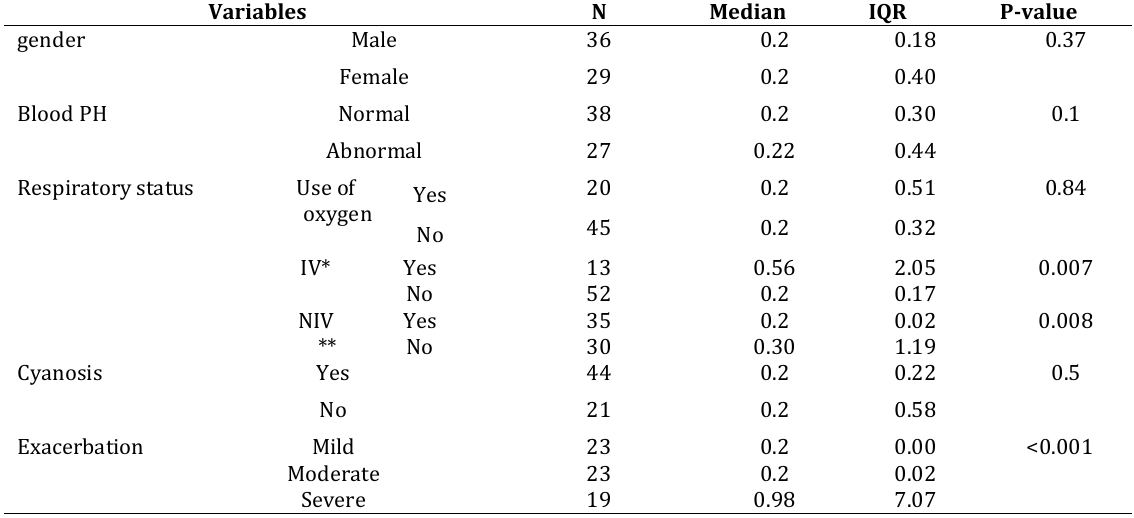
Table 2: Serum levels of procalcitonin in patients were studied by gender, blood pH, respiratory status, cyanosis, and exacerbation.